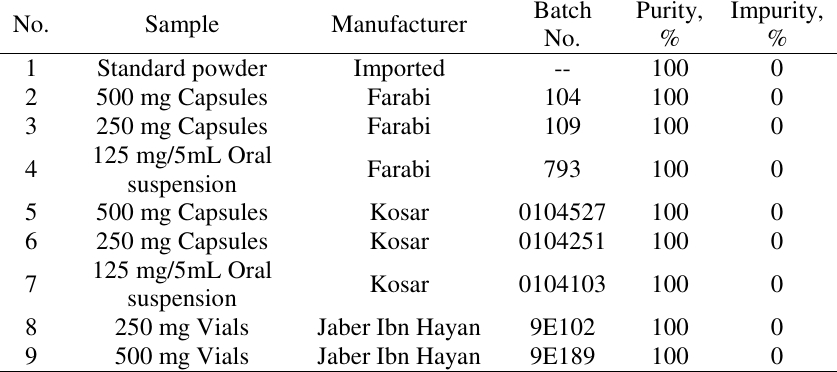
Table 3. Comparison of purity of cloxacillin products by HPLC method